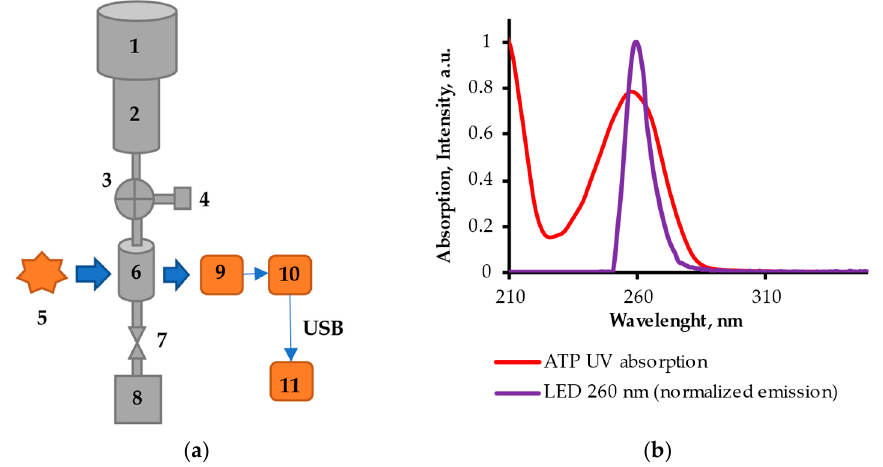
Figure 1. The general principles of the sensor operation: ( a ) Schematic diagram of the sensor; ( b )